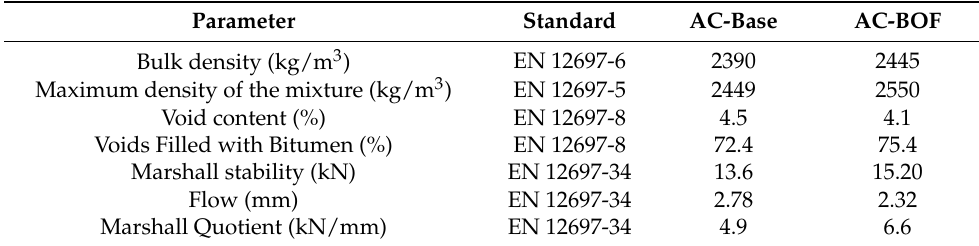
Figure 7. Particle size distribution gradations curves for conventional mix (AC-Base) and BOF slag mix (AC-BOF). Table 5. Summary of principal properties of tested